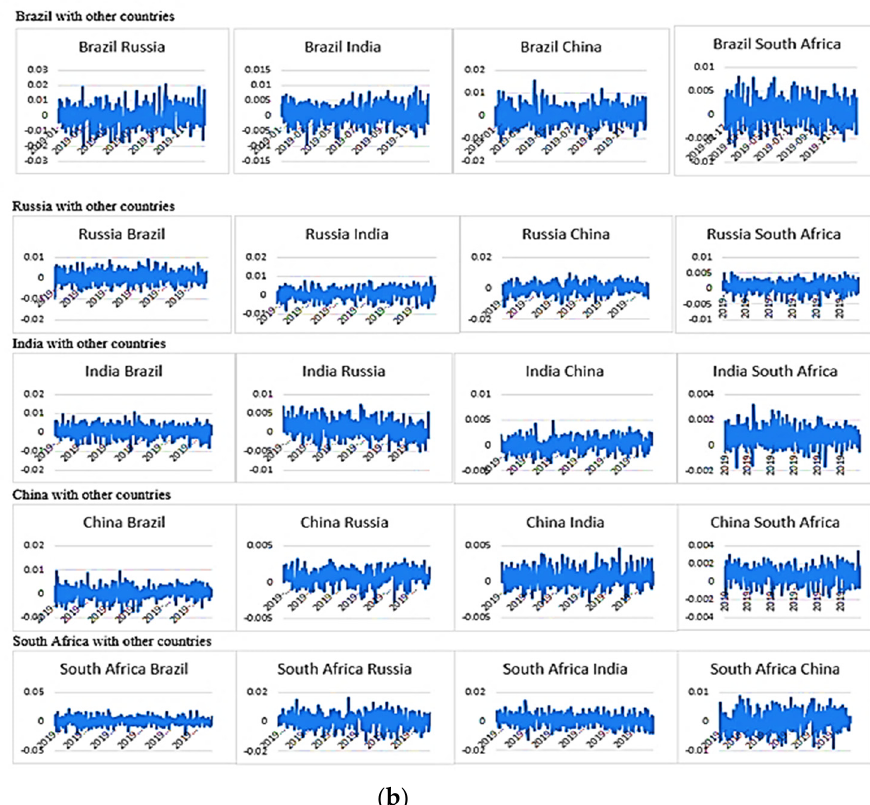
Figure 5. ( a ) Comparison of annual forecast data with real. ( b ) Forecast how one country influences another for year ahead.